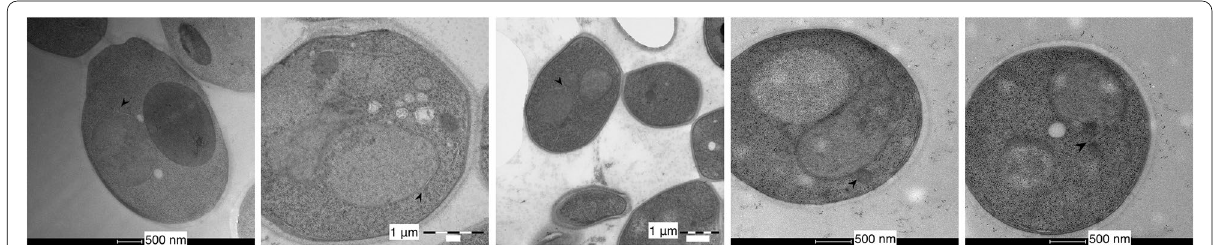
Fig. 9 Typical yeast images from the Cell Image Library (http:// celli magel ibrary. org/ groups/ 50815)